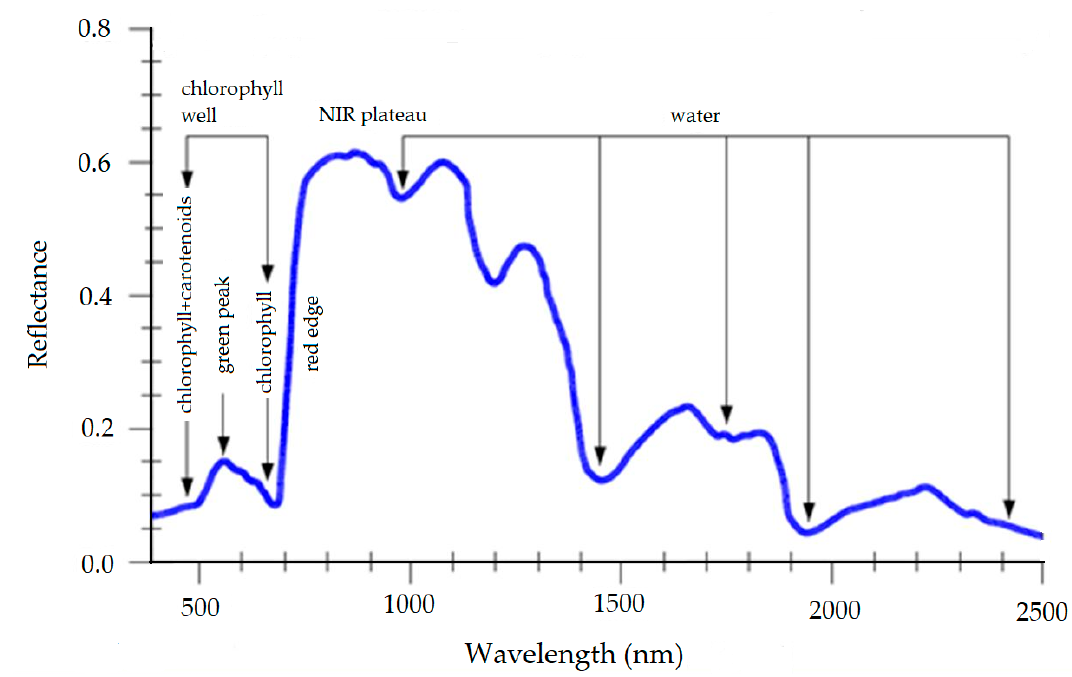
Figure 4. Typical healthy vegetation spectral signature.